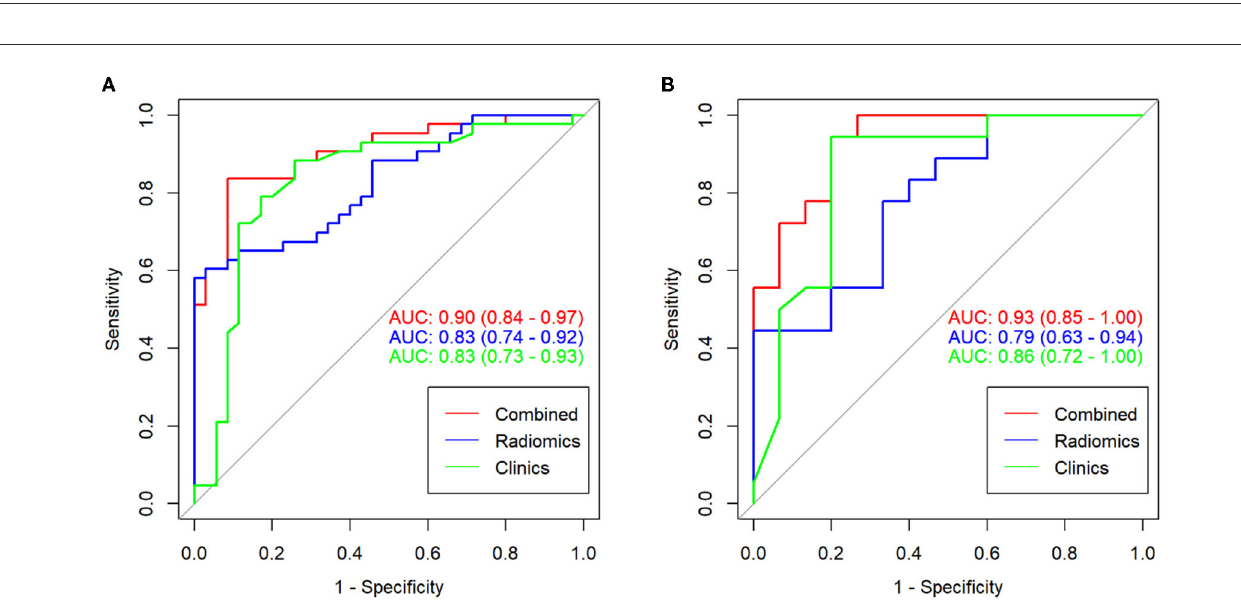
FIGURE4 ROC curves for the clinical model, radiomics model, and clinical-radiomics model in the training group (A) and the validation group (B)